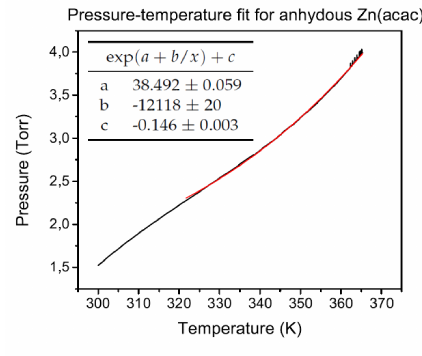
Figure 3. Fit of anhydrous zinc acetylacetonate vapor pressure curves.